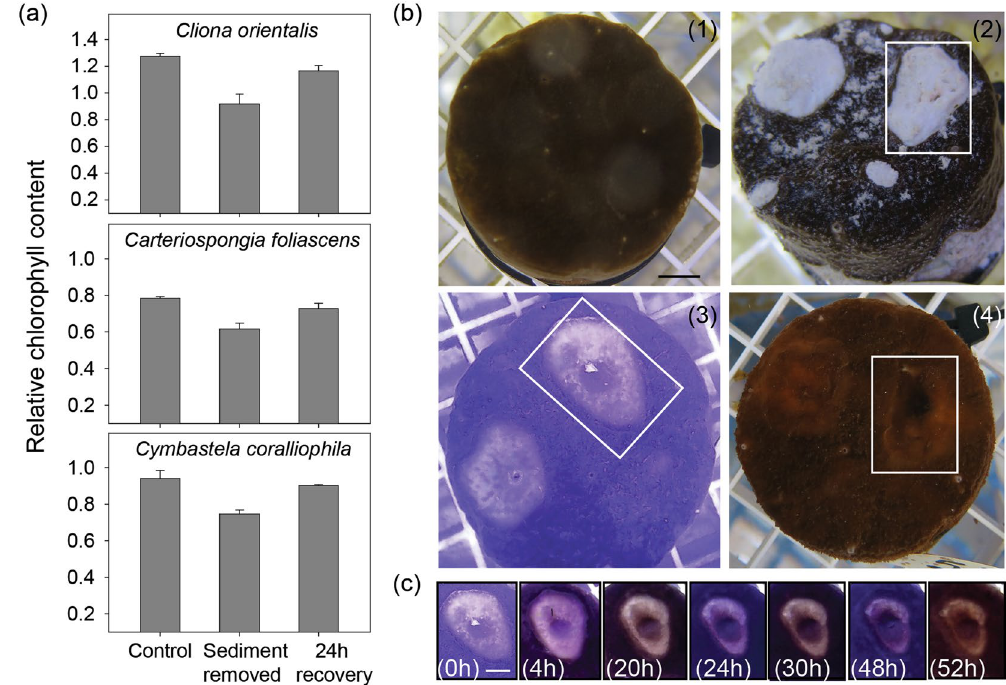
Figure 3. In-situ chlorophyll assessment using hyperspectral and time-lapse imaging. ( a ) Relative chlorophyll content of the three phototrophic sponge species smothered with sediments for 8 d (mean ± SE); ( b ) Bleaching recovery in C. orientalis following treatment with sediments for 30 d: (1) Before exposure to sediments (T = 0), (2) During smothering, (3) Bleached area (note white rectangle) evident following sediment removal, (4) Colouration after 6 d recovery; ( c ) Time-lapse recovery following sediment clearance (0 h) until 52 h later (scale = 1